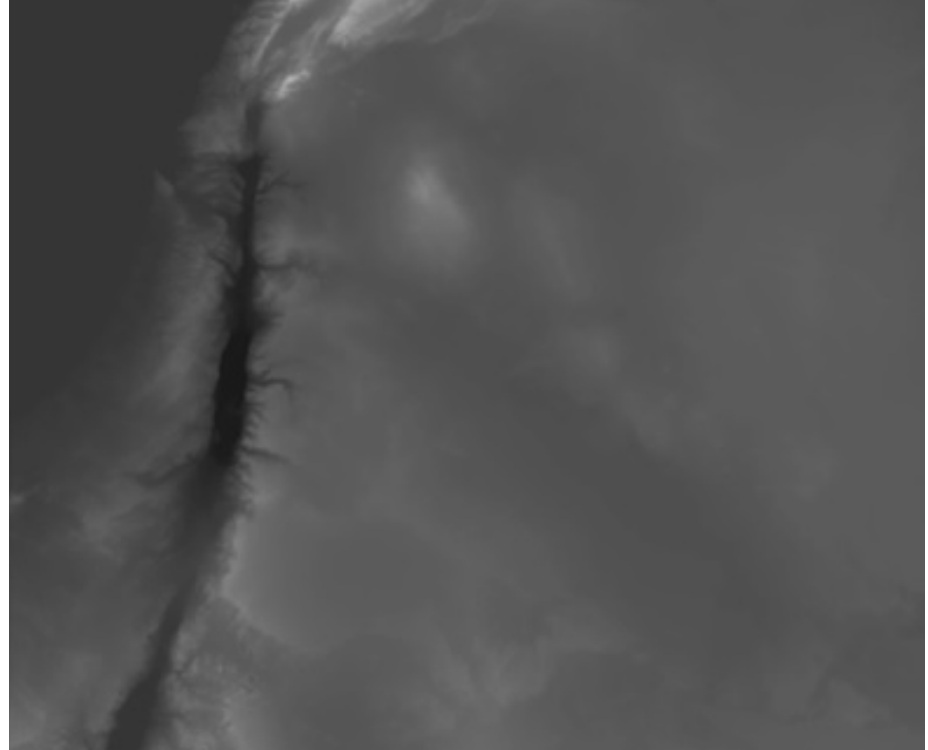
Figure 2. DEM raster image of the land around the area of Jordan (obtained from